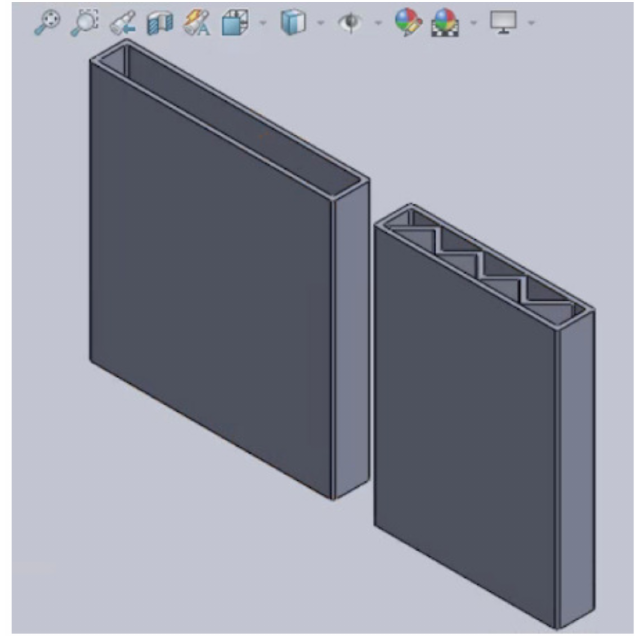
Figure 7. Black Buffalo wall configuration options